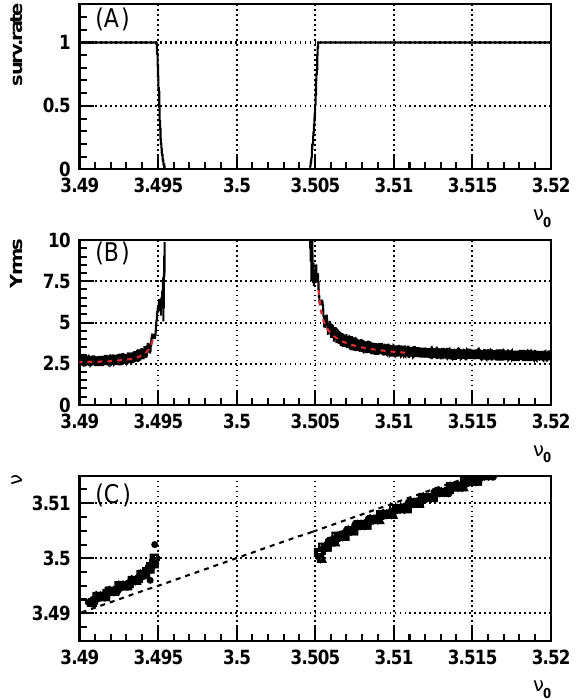
FIG. 8. (Color) Simulation results without the space-charge ef- fect. The betatron tunes are varied to cross the half-integer reso- nance upward or downward. The horizontal axis corresponds to the bare tune by Eq. (38). (A) Ratio of survival macroparticles. (B) rms size of simulated beam (solid line) and those obtained by the envelope equation (dashed line). (C) Observed tunes: the solid circles show the half of quadrupole mode coherent tune and the white characters show the tunes of single particles. The dashed line is an unperturbed tune, which is identical to n 0